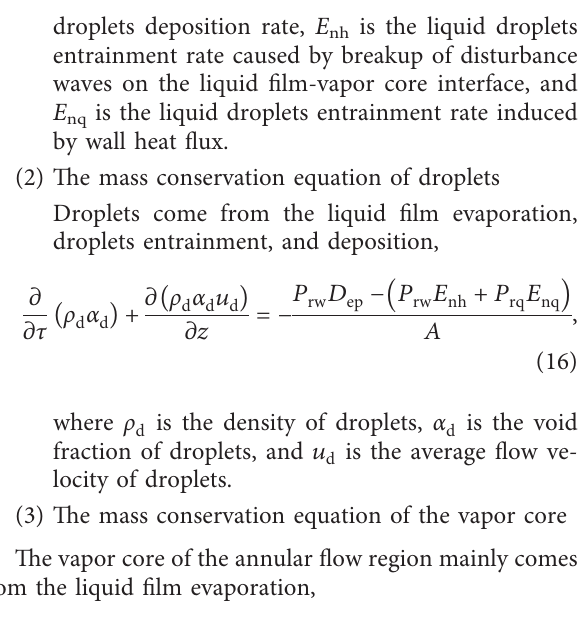
Figure 3: Conceptual sketch of liquid sublayer Dryout